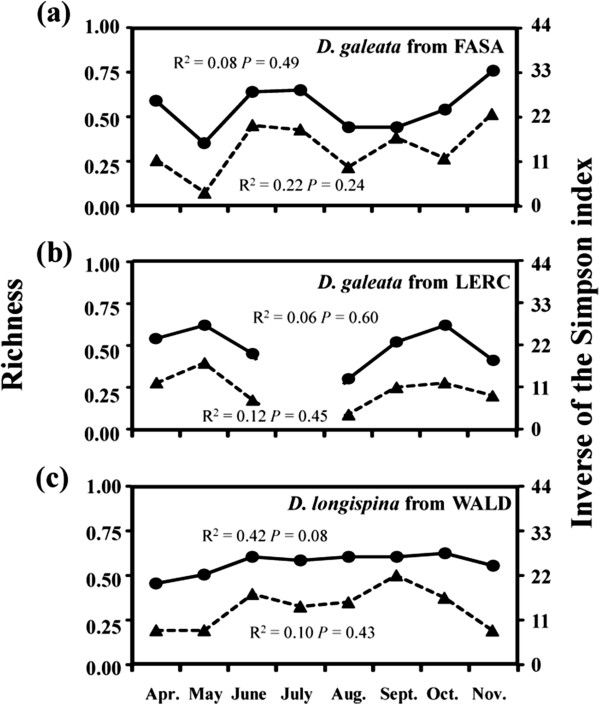
Temporal changes in clonal diversity, calculated as clonal richness R (solid line) or as the inverse Simpson index (dashed line) for (a) D. galeata from FASA, (b) D. galeata from LERC and (c) D. longispina from WALD (only in these three lakes were Daphnia communities present throughout the entire sampling season, i.e. from April to November 2011, and the sample size per analysed population ≥ 30). The upper/lower equation shows the results of linear regression analyses between time and clonal richness/inverse of the Simpson index, respectively. Missing data indicate a month when too few animals were available to calculate genetic indices of clonal diversity. The genetic indices were calculated based on variation at all 15 microsatellite loci (or 14 loci, if Daphnia could not be amplified at locus SwiD2).